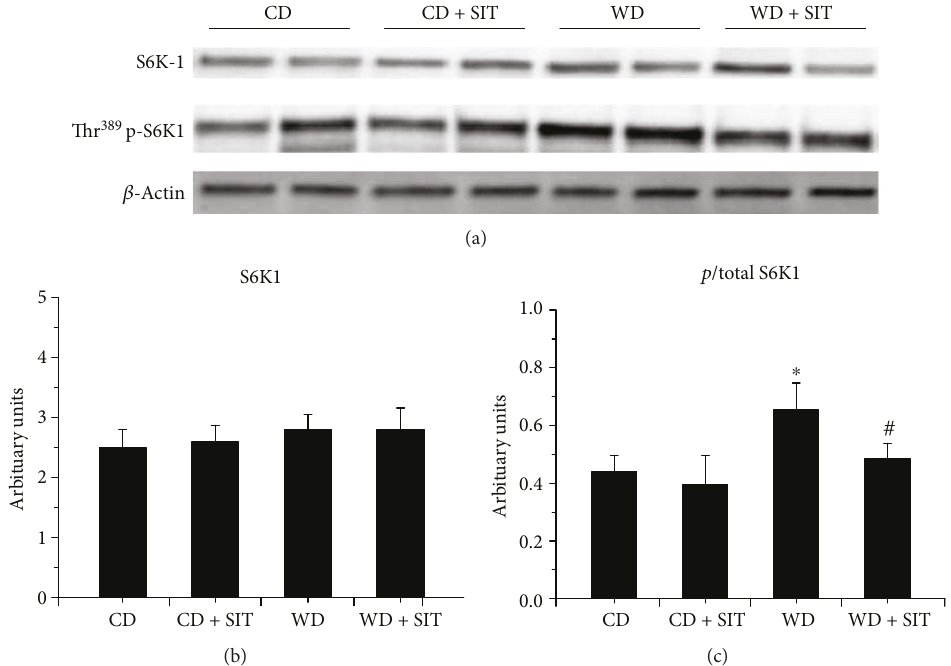
Figure 6: Western blot analysis of phosphorylated ( p ) and total S6K1 in pancreas tissue at the end of experiment. The ratio of thr- phosphorylation of S6K1 over total S6K1 increased in WD mice. SIT treatment reduced the ratio of p /total in WD mice signi fi cantly. ∗ P < 0 05 compared to the CD group; # P < 0 05 compared to the WD